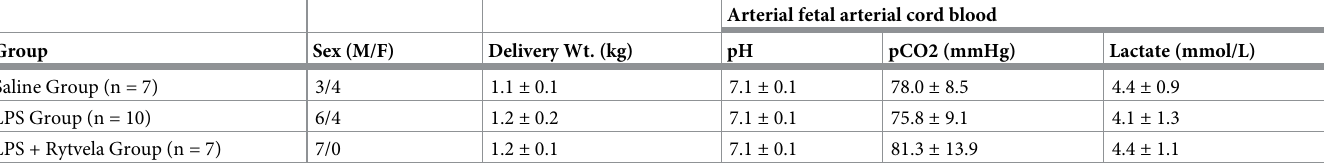
Table 1. Delivery